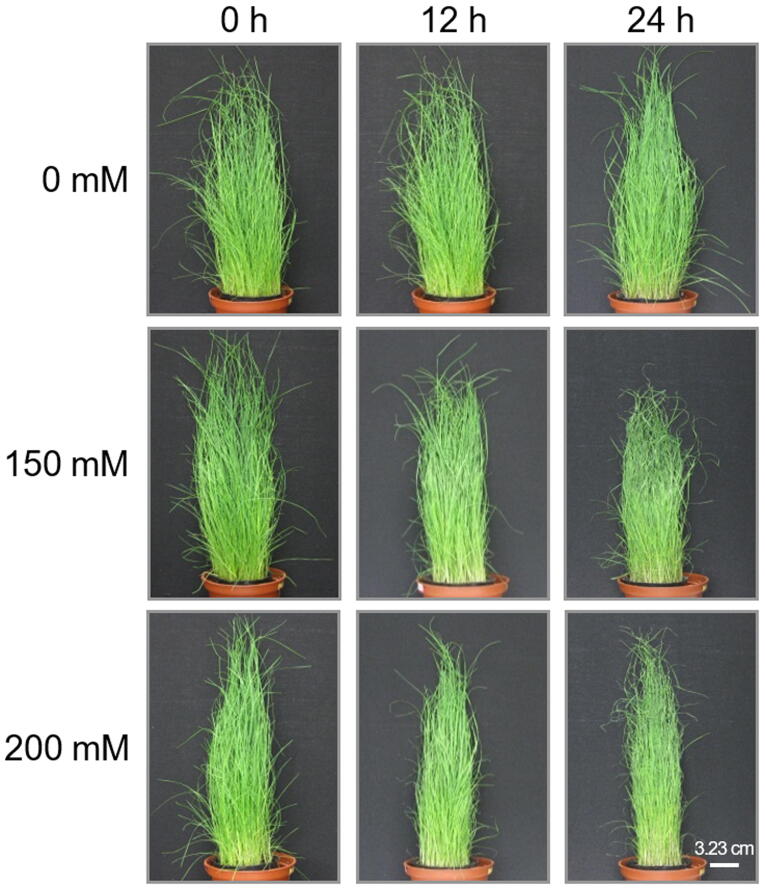
Morphological changes of alkaligrass seedlings grown under Na2CO3 treatment 50-day old seedlings were treated with different concentrations, 0 mM, 150 mM and 200 mM of Na2CO3 (pH 11) for 0, 12 and 24 h, respectively. Bar = 3.23 cm.